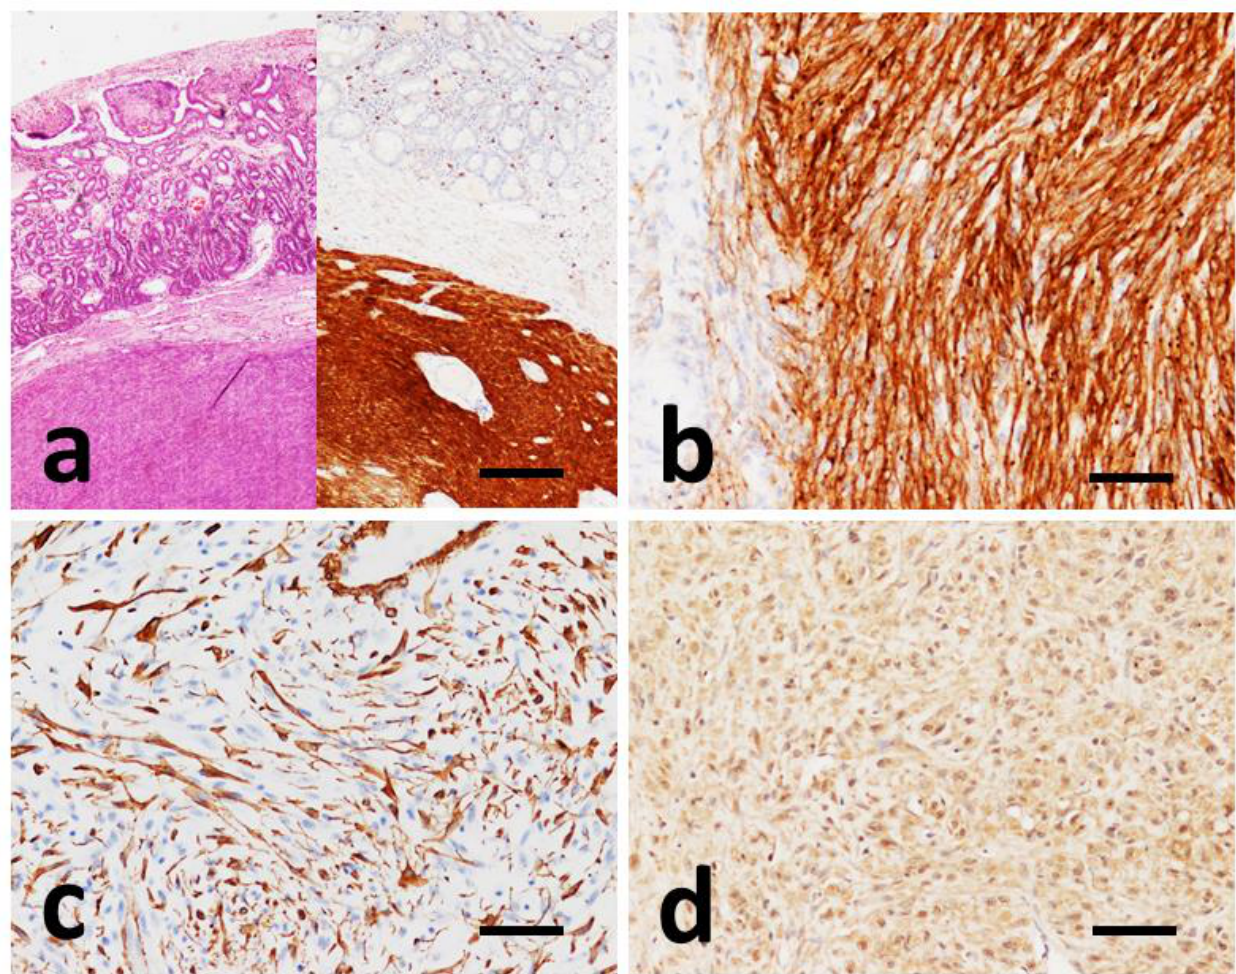
Figure 3. Immunohistochemical findings in GISTs. ( a ) Case #6, HE and IHC with CD117 of consecutive slides showing strong and uniform cytoplasmic CD117 positivity of the tumor mass. ( b ) Case #8, prevalent strong perinuclear dots and membranous staining of CD117. ( c ) Case #6, SMA positivity of neoplastic cells. ( d ) Case #4, cytoplasmic positivity to PDGFRα. ( a ) Scale bar 500 µm, ( b – d ) scale bar 100 µm.